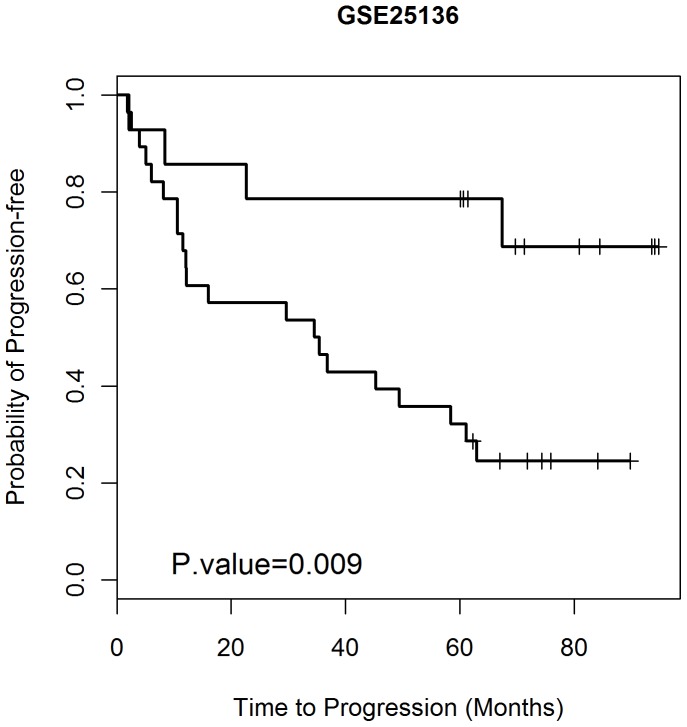
Survival analysis for the seven-gene Classifier with Gleason sum.Kaplan-Meier estimates of survival time of 42 independent patients in test Data Set 2 (GSE25136) according to the seven-gene Classifier with the Surgical Pathology-determined Gleason sum. The Gleason sum variable has the same weighting as each gene in the determination of classification.